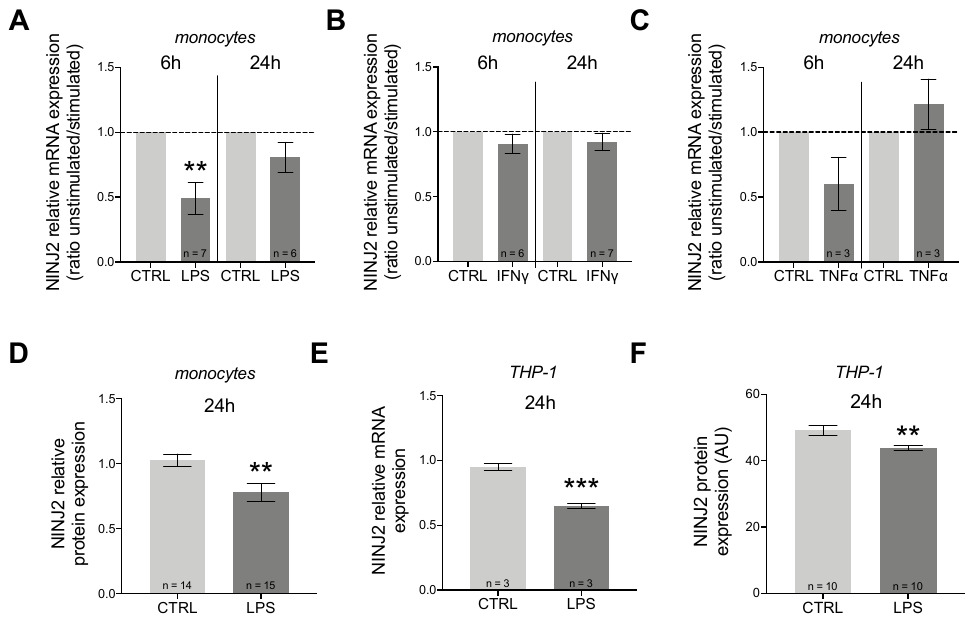
Figure 1. NINJ2 is down-regulated after pro-inflammatory stimulation in monocytes and in THP-1 cells. The relative expression of NINJ2 gene was measured in ( A ) human monocytes stimulated with LPS (1 µ g/mL) for 6 h or 24 h, ( B ) human monocytes stimulated with IFN γ (100 ng/mL) for 6 h or 24 h, ( C ) human monocytes stimulated with TNF α (10 ng/mL) for 6 h or 24 h. Data are reported as ratio between stimulated and unstimulated (CTRL) conditions (mean ± SEM), with the number of individuals analyzed for each condition reported. p -values were calculated according to paired t -test starting from the relative expression values for each sample. ( D ) The relative protein expression of NINJ2 was measured in monocytes collected from 3 HCs and stimulated with LPS (1 µ g/mL) for 24 h; data are reported as mean ± SEM from a total of 15 analyzed cells; p values were calculated with unpaired t -test. ( E ) The relative NINJ2 transcript level was measured in THP-1 cells stimulated with LPS (1 μ g/mL) for 24 h; experiments were performed in triplicate and results are reported as mean ± SEM. ( F ) NINJ2 protein level, expressed as mean fluorescence (arbitrary units, AU), was measured in THP-1 cells stimulated with LPS (1 μ g/mL) for 24 h; data are reported as mean ± SEM from a total of 10 analyzed cells for each condition. CTRL: unstimulated condition, LPS: stimulated condition.** p < 0.01, *** p < 0.001.